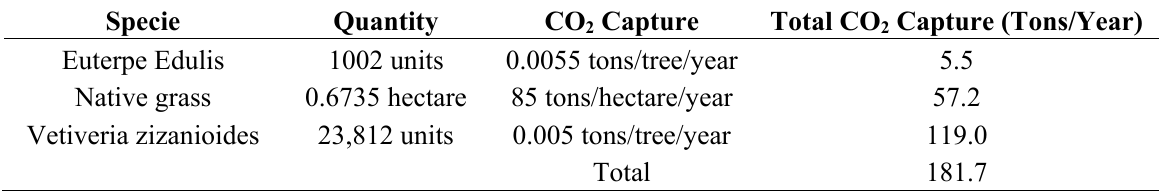
Table 3. Vegetal species quantities and GHG capture per